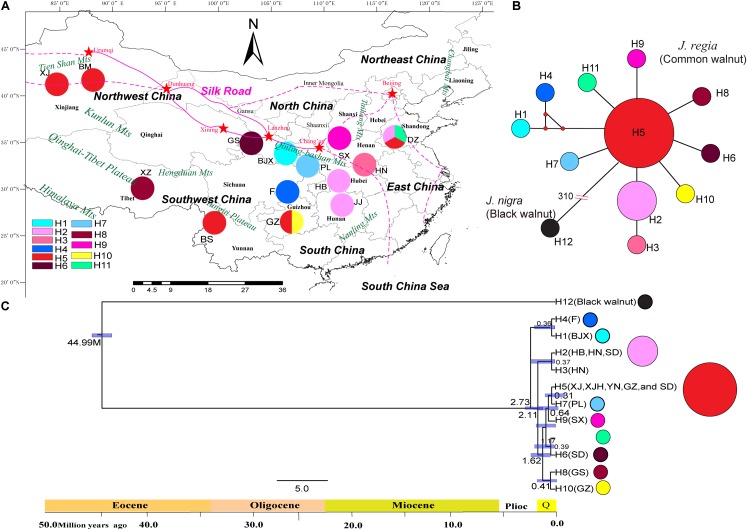
Geographical distribution of haplotypes of 17 individuals of common walnut (Juglans regia). (A) Geographical distribution of 11 chloroplast haplotypes in J. regia and sampled locations. Colors of haplotypes correspond of those of the small figure in the left corner of the map. (B) The minimum spanning network of 11 chloroplast genome haplotypes rooted by J. nigra. In the network diagram, small red circles indicate intermediate haplotypes not detected in the dataset; red split lines and numbers indicate mutation steps supported by indels, while black lines indicate one mutation step supported by indels. The black circles indicate the haplotype of J. nigra. The small red dot indicated that the mutation step. The number “310” on the truncation of a branch of black walnut represent a total of 310 mutation steps. No red dot between haplotypes represent only one mutation step. (C) BEAST-derived chronograms of 11 chlorotypes of J. regia based on whole genome sequences. Blue bars and the numbers above the bars indicate 95% highest posterior densities (HPDs) of time estimates [million year ago (Mya)].